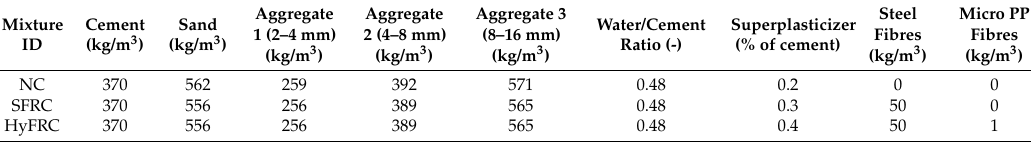
Table 1. Description of concrete mixture used in the test program.